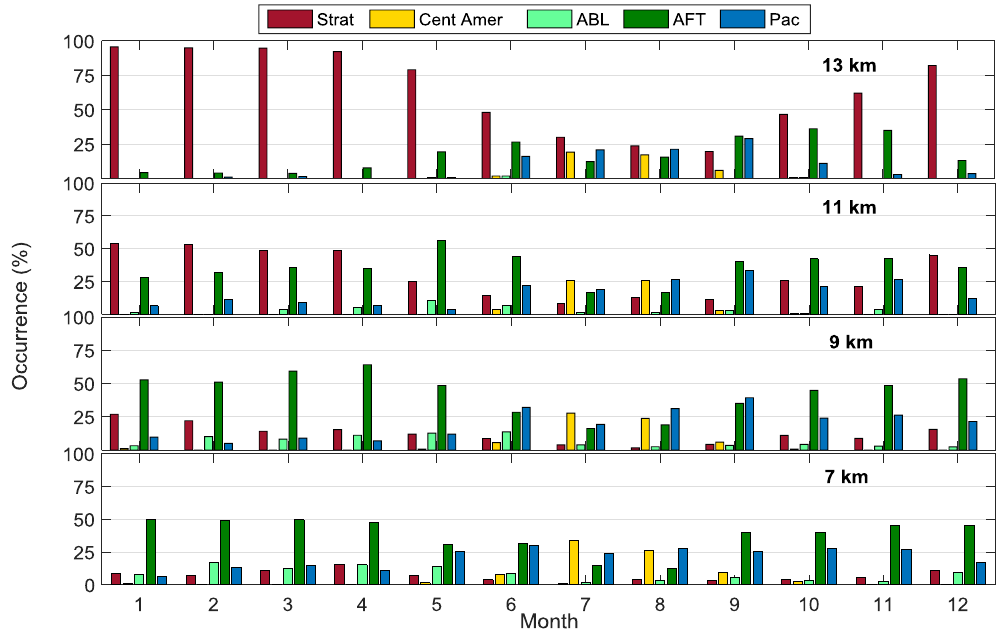
Figure 9. Distribution of the five categories identified for each trajectory ending at TMF during the lidar measurements over the period 2000–2015. The number of occurrences is given in percentage for each month of the year, and for four different altitude layers.